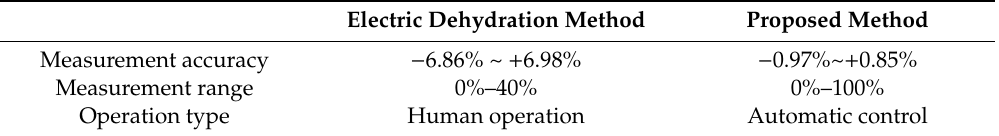
Table 2. Comparison of detection results with the proposed method and traditional o ffl ine